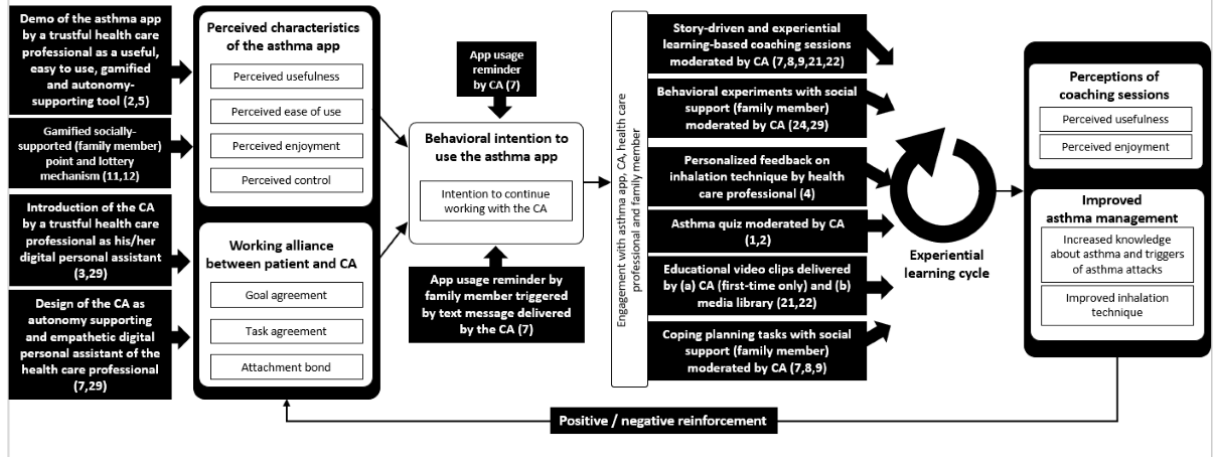
Figure 1. Conceptual model of the intervention. Intervention components are represented by black boxes; behavioral change technique numbers [65] are listed in brackets for each intervention component. CA: conversational